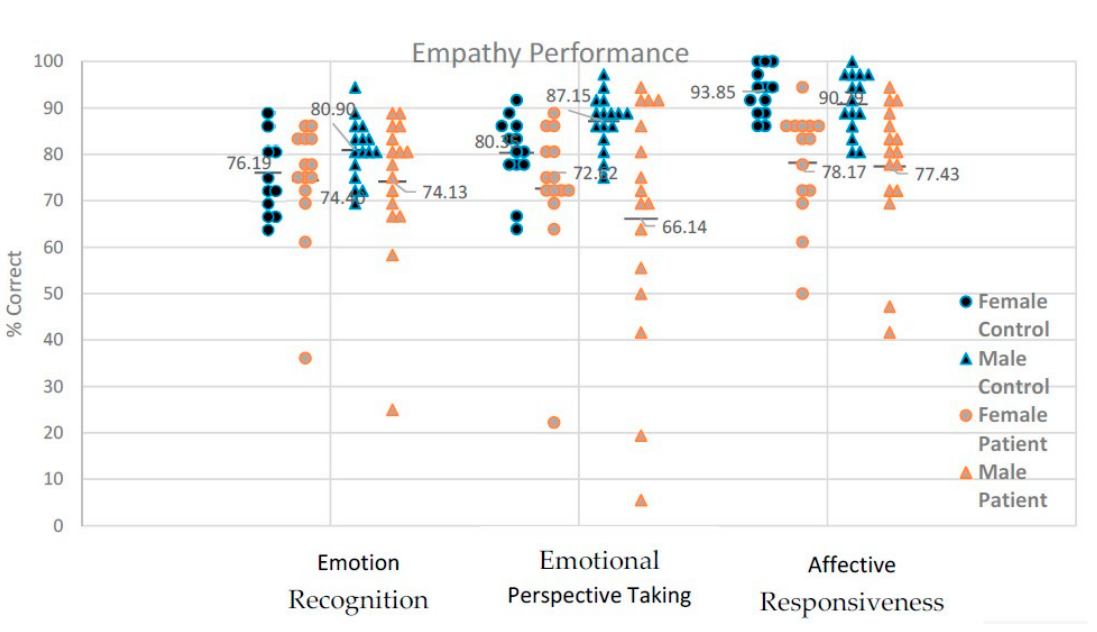
Figure 2. Performance (% correct and a line indicating mean group performance) in emotion recognition, emotional perspective taking, and affective responsiveness in schizophrenia patients and healthy controls.